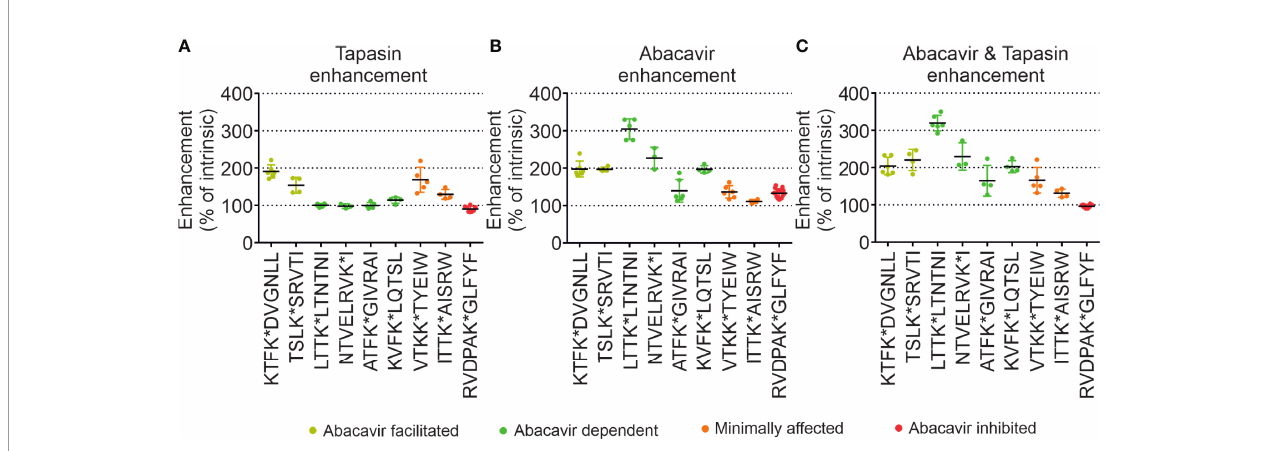
FIGURE 6 | Tapasin and abacavir differentially enhance the binding of fl uorescent peptides. The extent that (A) tapasin, (B) abacavir, or (C) the combination of both enhanced the binding of fl uorescent peptides to HLA-B*57:01fos molecules was compared over independent experiments. For each polarisation measurement taken in an experiment the enhancement factor was calculated by: dividing polarisation in the presence of tapasin (or abacavir or both) by the intrinsic polarisation level; multiplying by 100 to obtain a percentage; and calculating the mean enhancement for the experiment. The enhancement factors obtained from different experiments are shown as dots, with the mean average shown as a horizontal black bar, and the standard deviation of multiple experiments shown as a coloured vertical line edged with horizontal bars. Peptides are coloured according to their classi fi cation by mass spectrometry: abacavir facilitated = yellow, abacavir dependent = green, minimally affected = orange, abacavir inhibited =